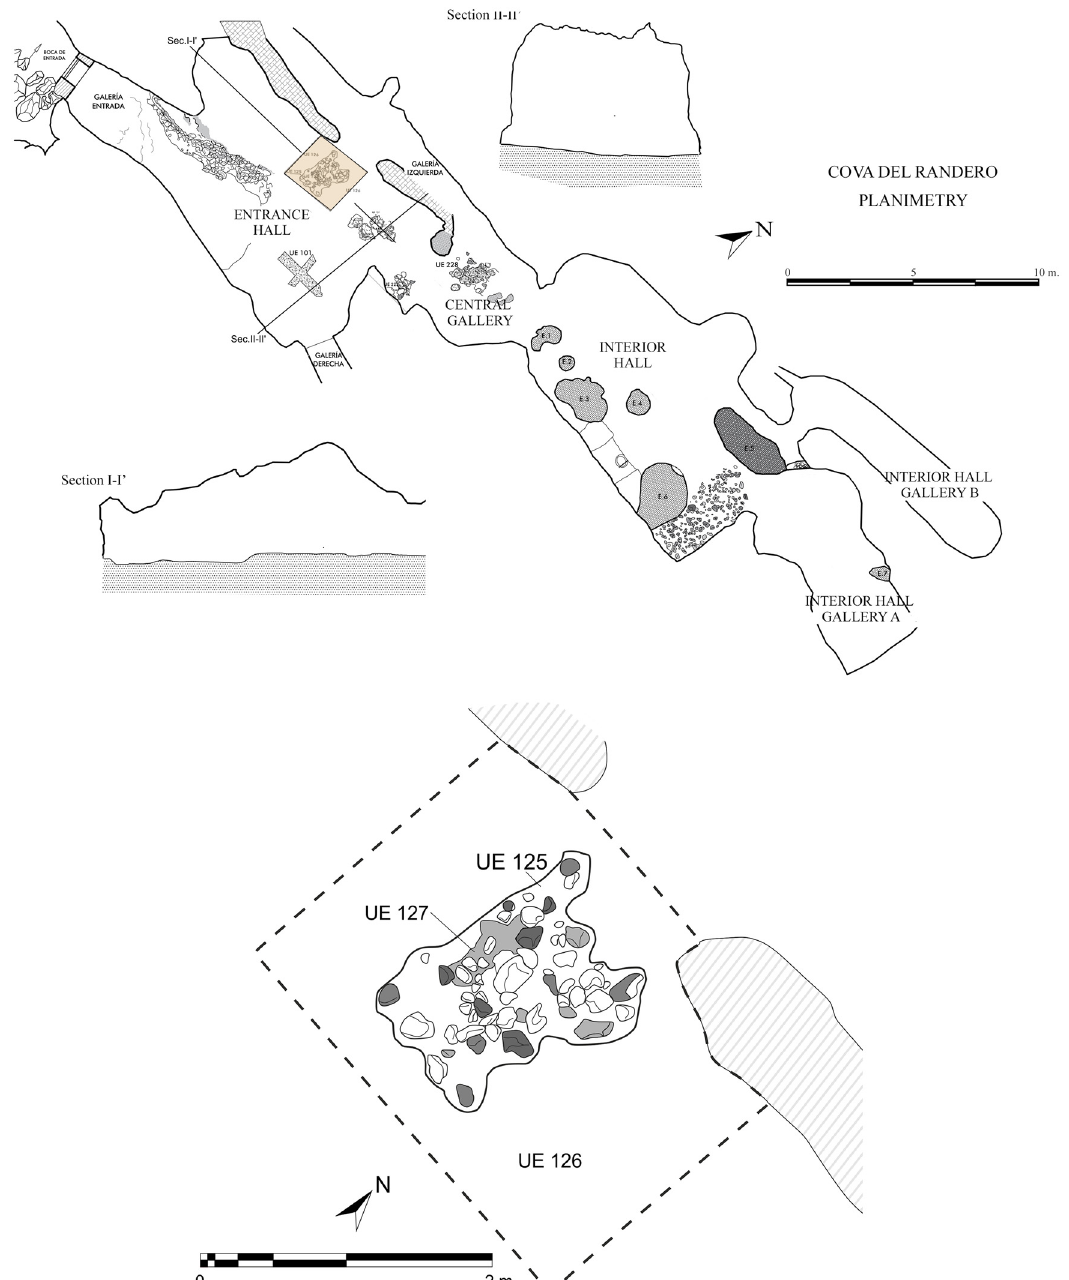
Figure 2: Planimetry of the cave and sections of the